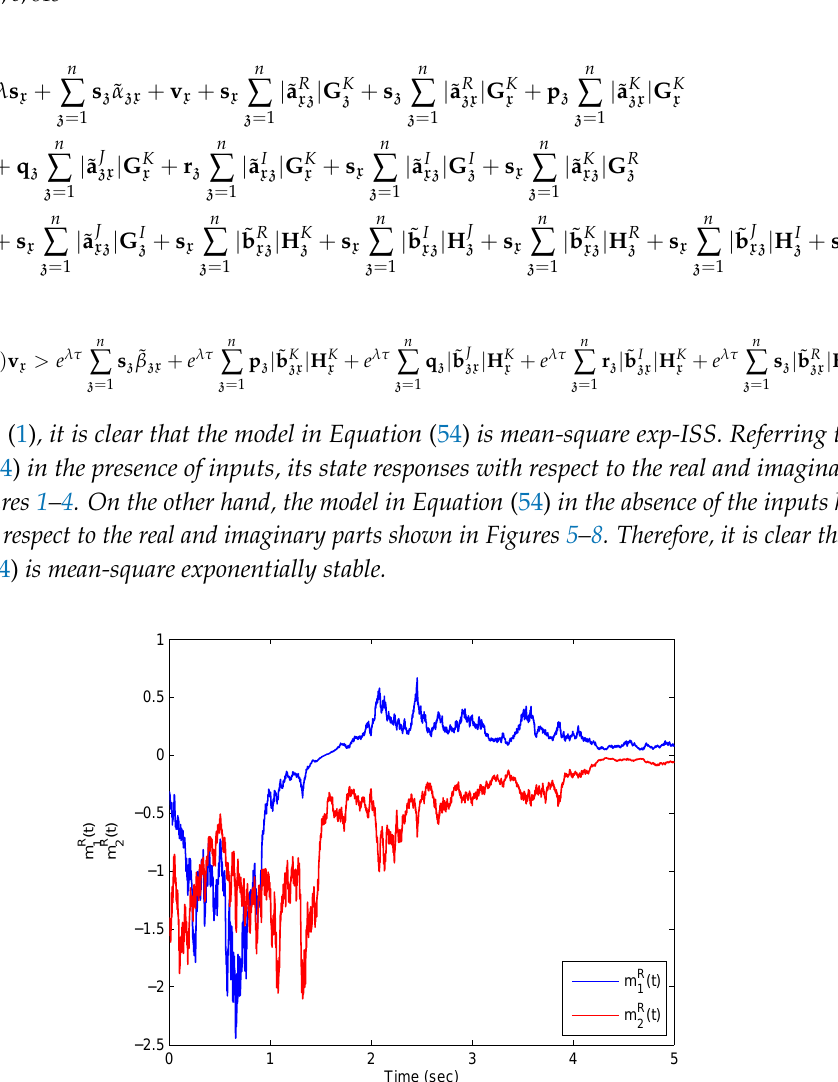
Figure 1. A time response plot with respect to the states m R model in Equation (54) in which U (cid:54) = 0.